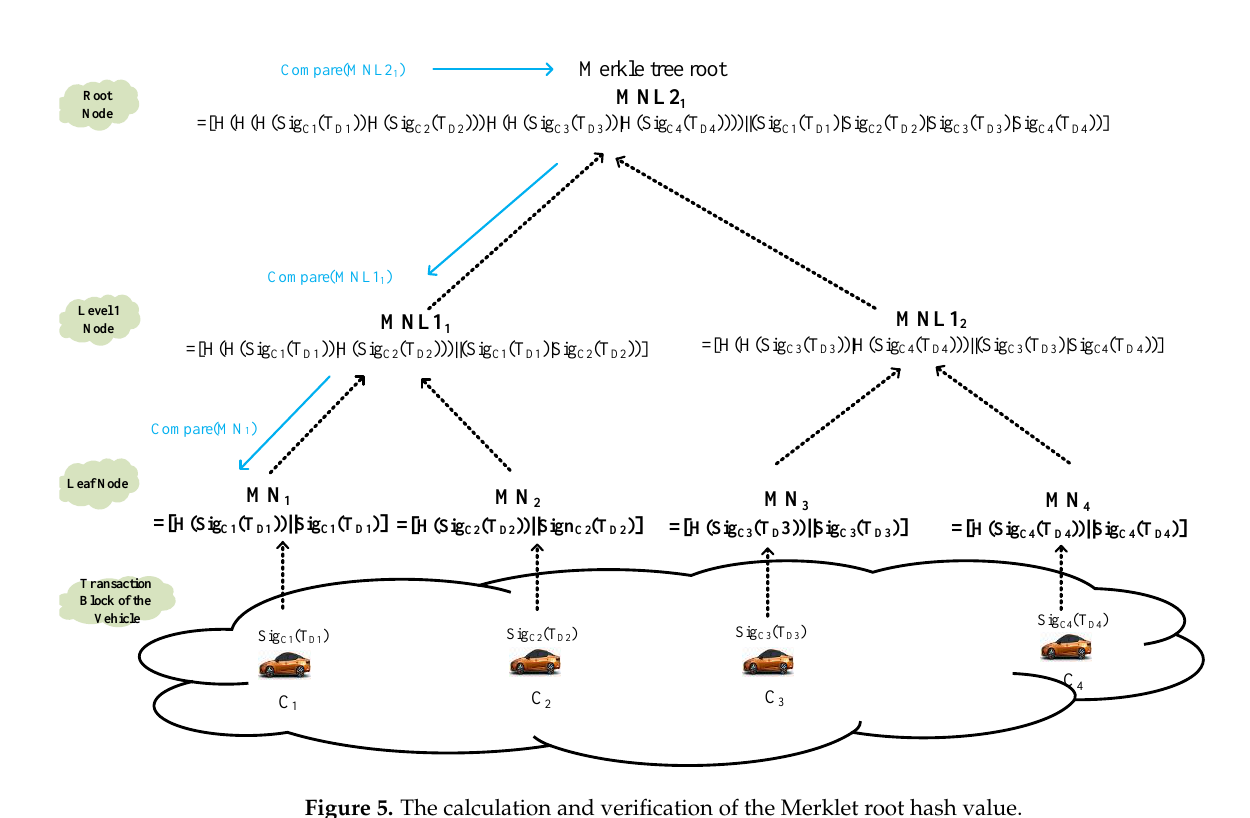
Figure 7. The detailed structure of the intra_clusterBC. 3.2. Information Security Transmission Method Between IoVs And Routers When the intra_clusterBC x is complete, the base station BS x is responsible for trans- mitting the intra_clusterBC x to the cloud service platform VM master , and the transmission process must pass through the router to protect the intra_clusterBC x information. This study adopts the elliptic curve cryptographic exchange protocol, ECDH, to protect the transmitted data. Here, we assume that the base station BS x and router are secure and certified before deployment. The delivered data are routed through the BS 1 → R 1 → R 2 → R 3 → R 4 → PKI VM master path, as shown by the red line in Figure 4. Initially, the vehicle digitally signs the transaction block using ECDSA and then per- forms a hash operation through the RSU to obtain the hash value of the Merkle tree root and the complete block. When each RSU performs similar operations and individually transmits its blocks to the BS, the BS can concatenate the received blocks into an intra_clus- terBC. The router then transfers the intra_clusterBC to the destination, VM master . In this study, ECDH key agreement is used on the routing side, and the two parties use the ECDH conference key to cipher and decipher the transmitted data [21]. The ECDH mechanism is similar to the traditional Diffie – Hellman key exchange protocol, where both sides set up a conference key over an unsecured channel [22]. Since asymmetric cryptosystems have a key length of at least 1024 bits, they offer an elevated grade of security. However, ECDH